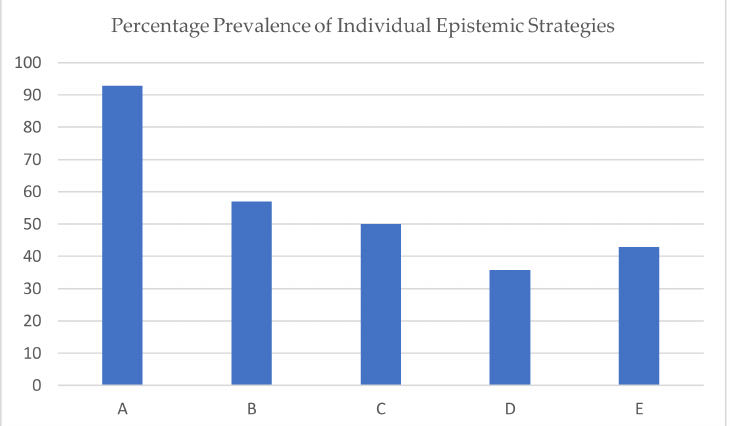
Figure2. PrevalenceofIndividualEpistemicApproachesinDi ff erentEpistemicApproachCombinations where A = Verification, B = Experimental Validation, C = Sensitivity Analysis, D = Inter-model Comparison, E = Justification for use of simulations over conventional